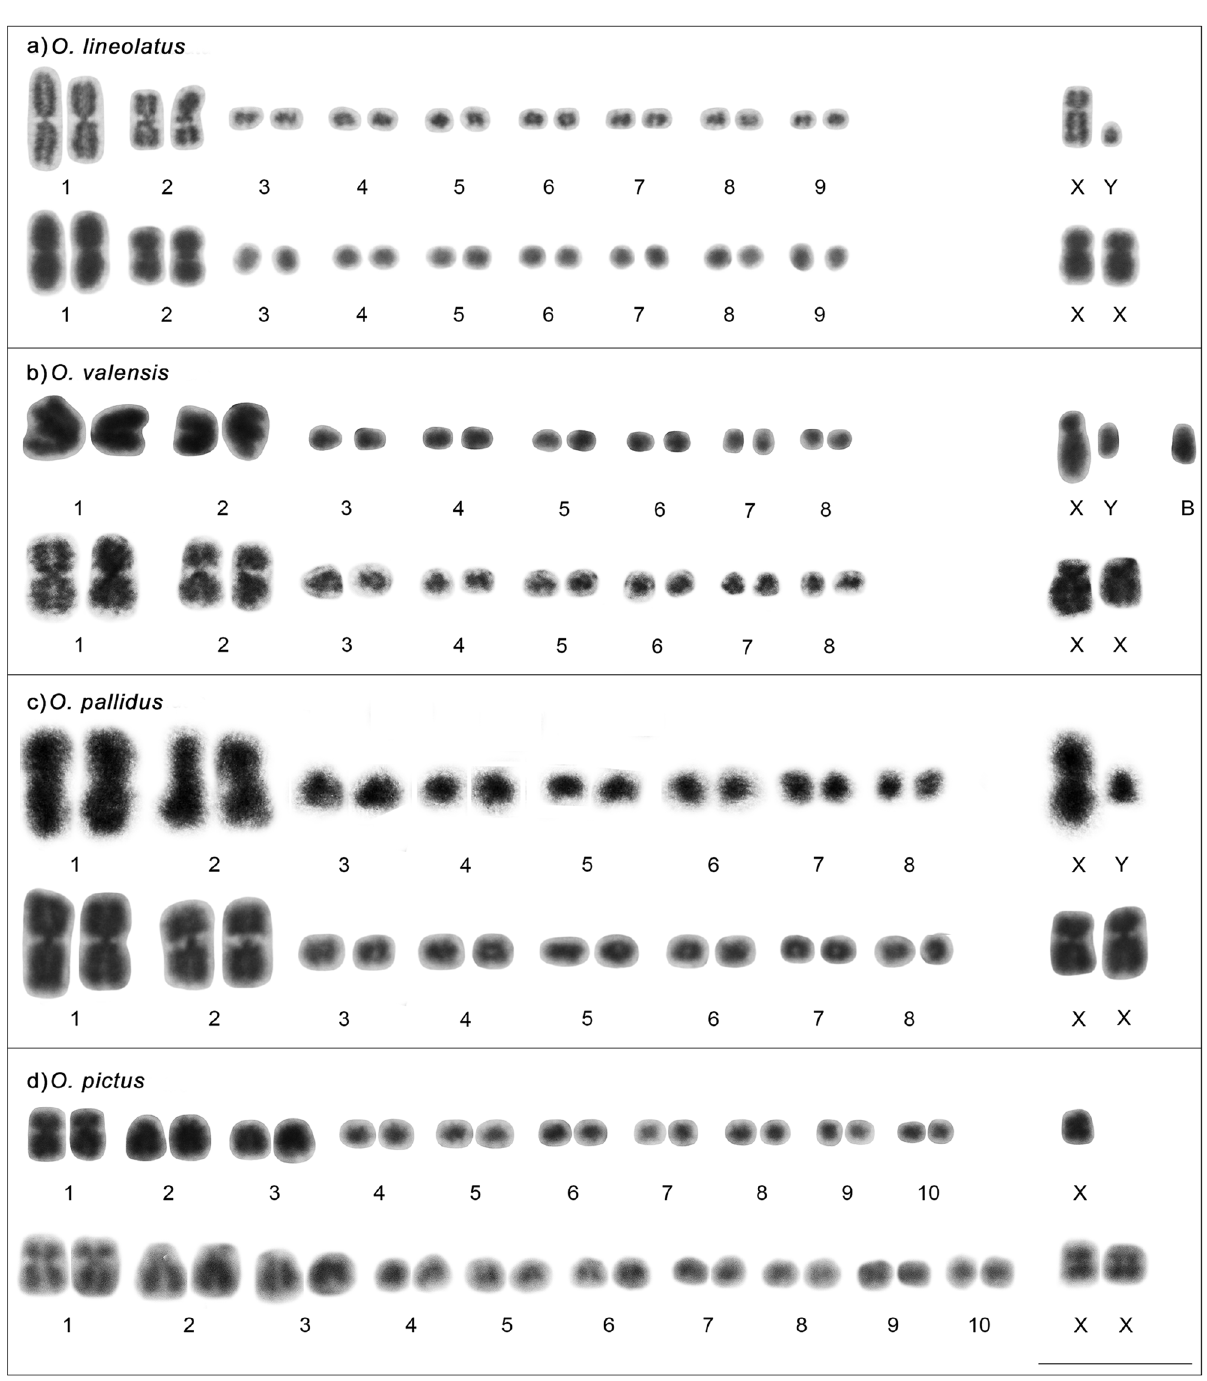
Figure 1 – Mitotic karyotype of (a) Oecanthus lineolatus with 2n = 20, XY♂/ XX♀; (b) O. valensis with 2n = 18, XY♂/ XX♀ and one chromosome B in the male karyotype; (c) O. pallidus with 2n = 18, XY♂/ XX♀; and (d) O. pictus with 2n = 21, X0♂/ 22, XX♀. Scale bar = 10